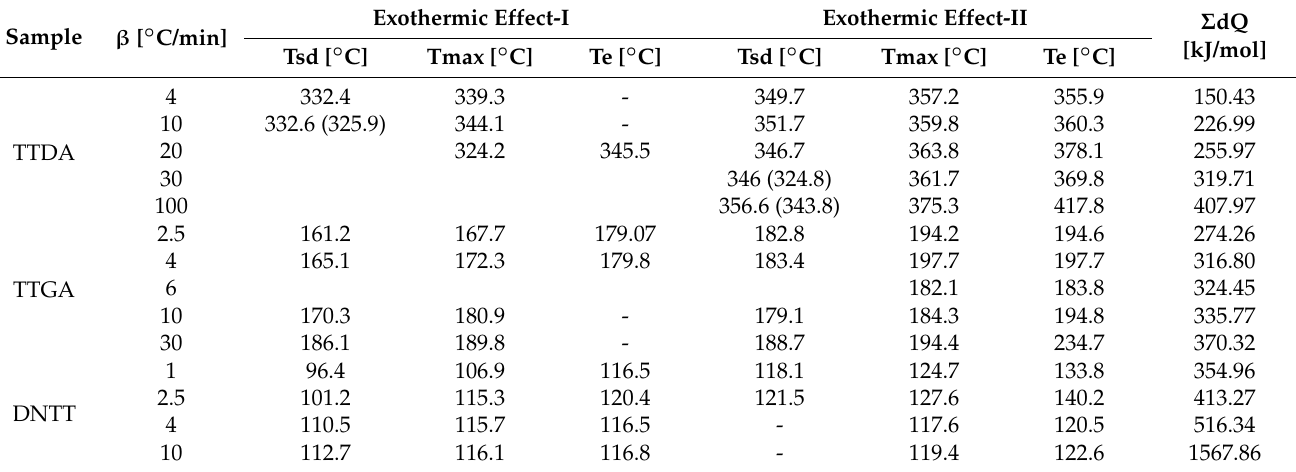
Table 4. Decomposition points of samples according to DTA